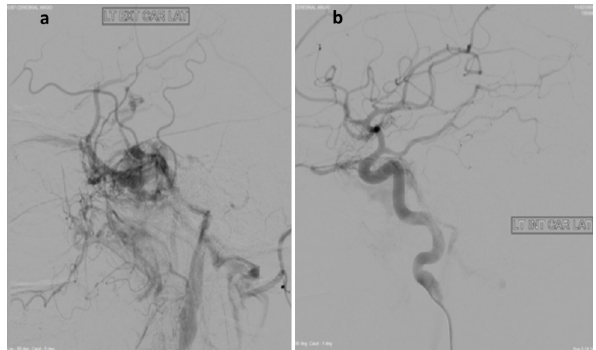
Figure 2: Digital subtraction angiogram confirming an indirect type D carotid cavernous fistula with communication between cavernous sinus and the dural branches of left (a) external carotid artery (b) and internal carotid artery.